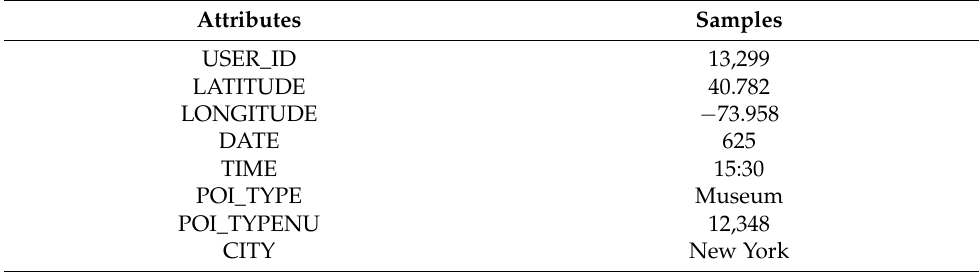
Table 1. Details of social media check-in data.